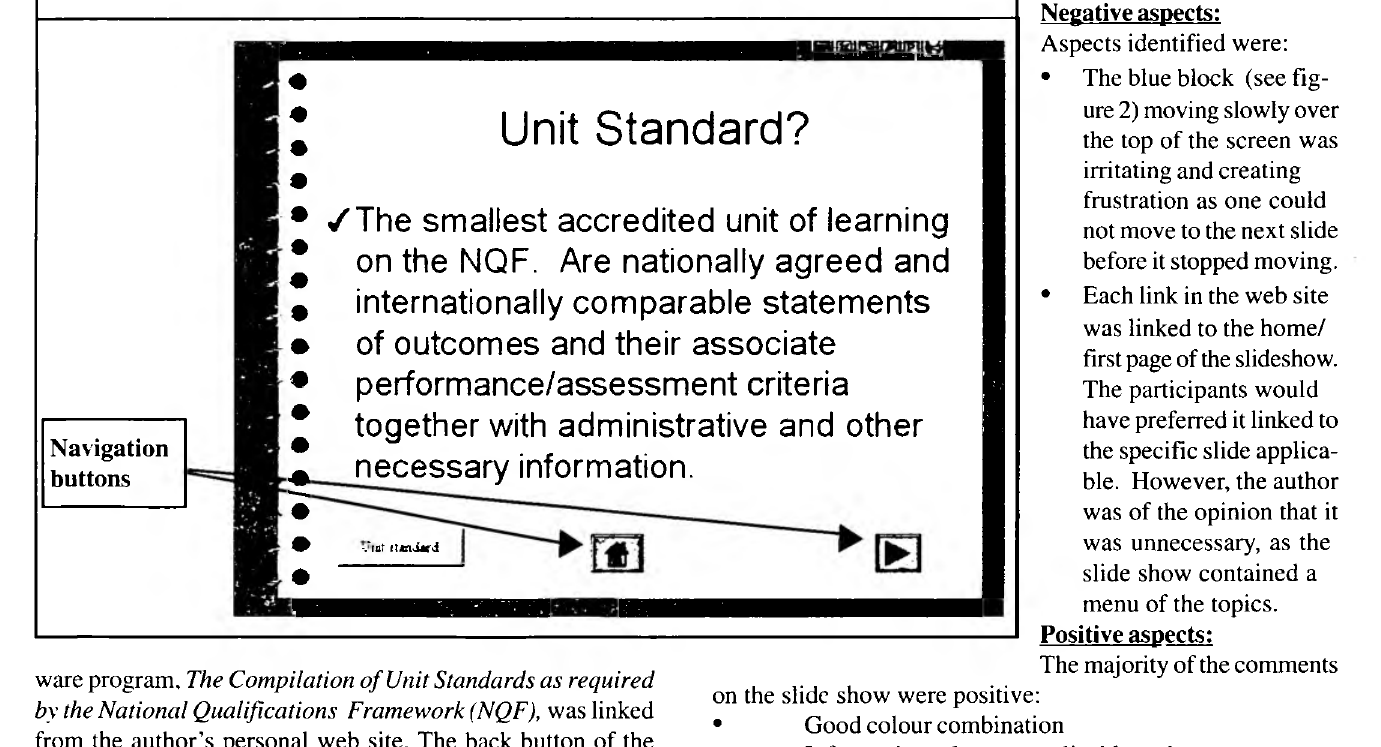
Figure 5 : One slide of the slideshow